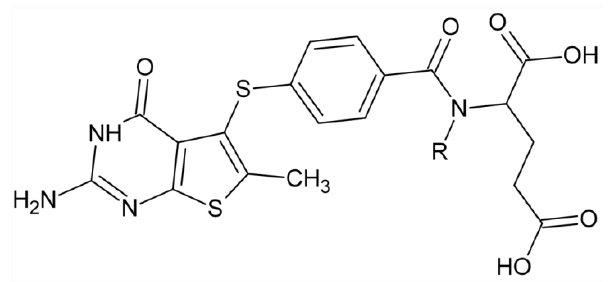
Figure 10: Structure of newly designed